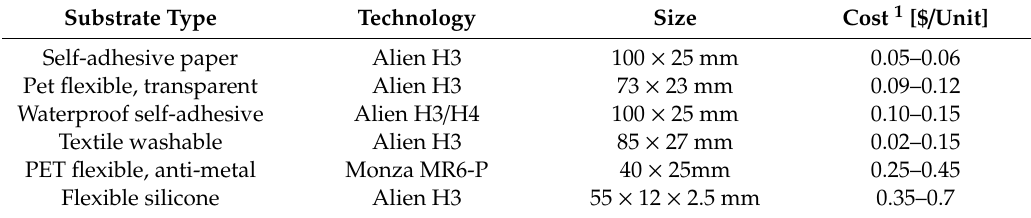
Table 6. Comparison of UHF RFID passive tags with di ff erent material substrates.